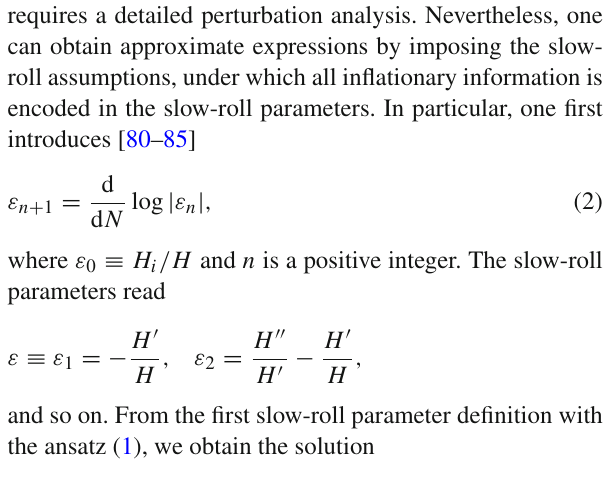
For Γ → 0 all of the slow-roll parameters with n ≥ 3 yield the value − 1 / N . However, in the general case, all of the slow parameters have small values if the ε 2 is